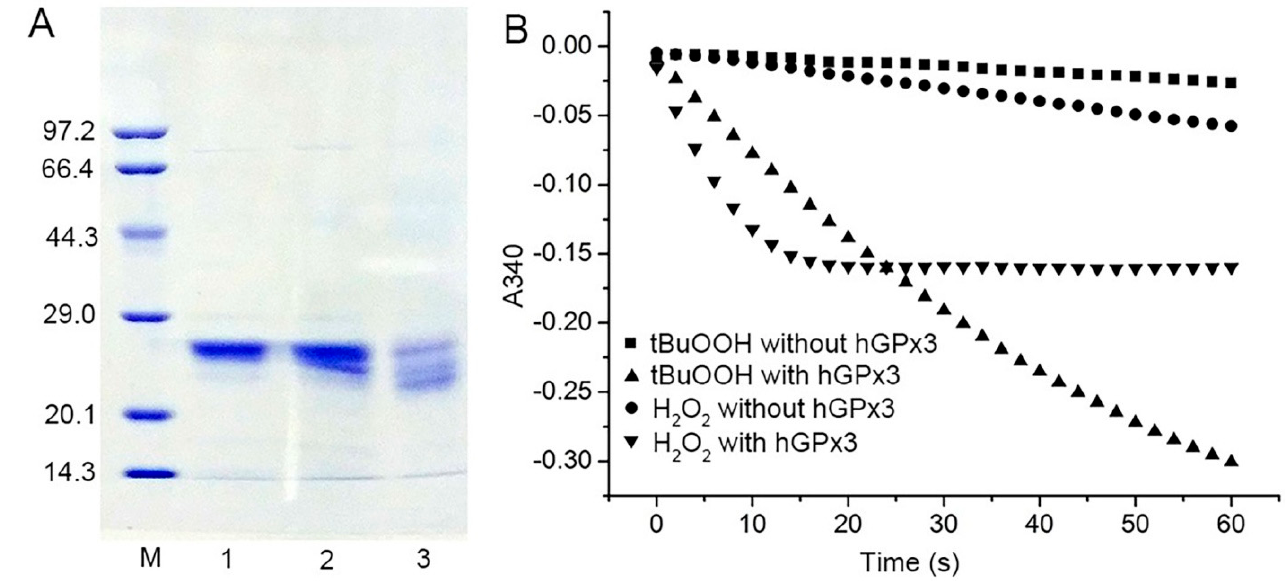
Figure 1. Expression, purification, and enzymatic activity of Sec − hGPx3; ( A ) SDS − PAGE analysis of purified Sec − hGPx3 under reducing conditions (Lane 1), reducing conditions without heat − denaturation (Lane 2) and non − reducing conditions without boiling treatment (Lane 3). M, molecular mass markers; ( B ) Enzymatic activity of Sec − hGPx3 (2.5 µ g) was assessed through the decrease of absorbance at 340 nm over time upon the addition of tert − butyl hydroperoxide (t − BuOOH) (60 μ M, triangle) or H 2 O 2 (60 μ M, upside − down triangle) to a cuvette containing glutathione reductase (GR) (1 U), GSH (1 mM), and NADPH (0.25 mM). Control reactions were spontaneous reduction of H 2 O 2 (circle) and t -BuOOH (squares) without Sec − hGPx3.